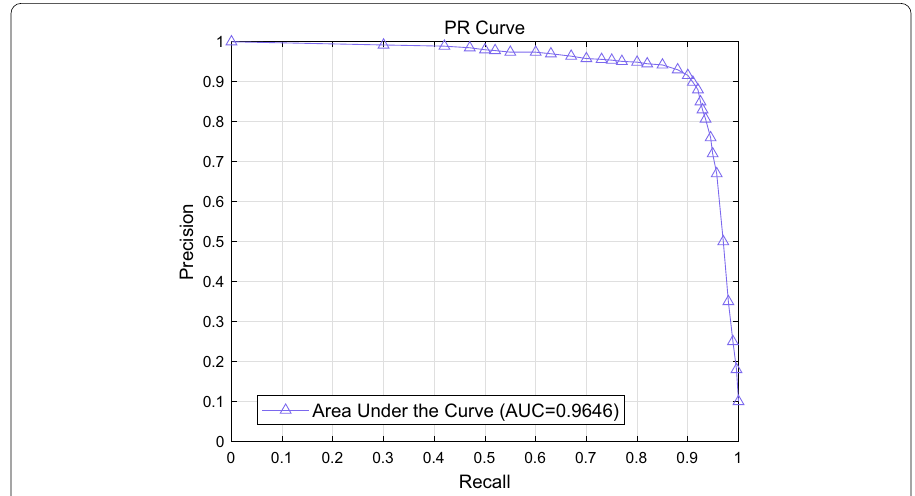
Fig. 16 PR curve of pulmonary nodule classification which plots recall against precision